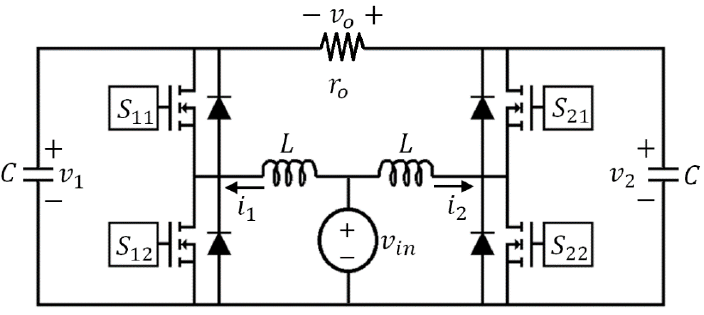
Figure 1. Schematic diagram of the boost inverter circuit.